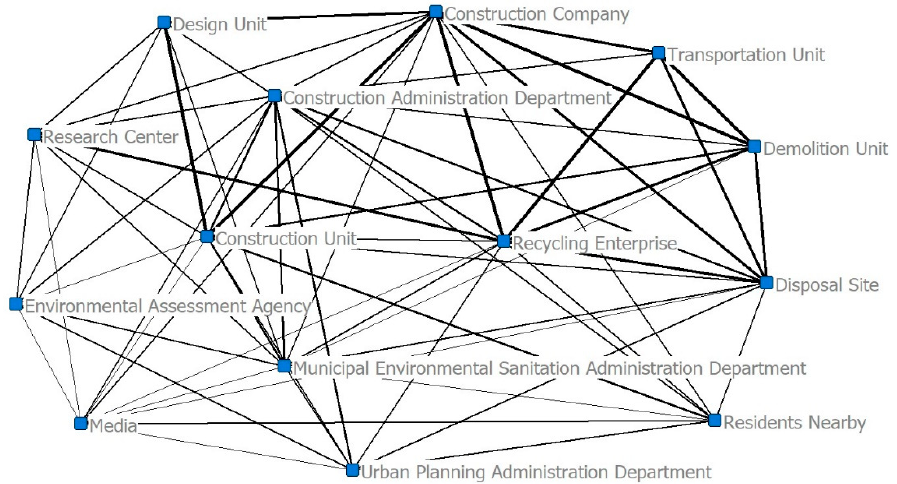
Figure 3. Model graph of governance relationship network among stakeholders.